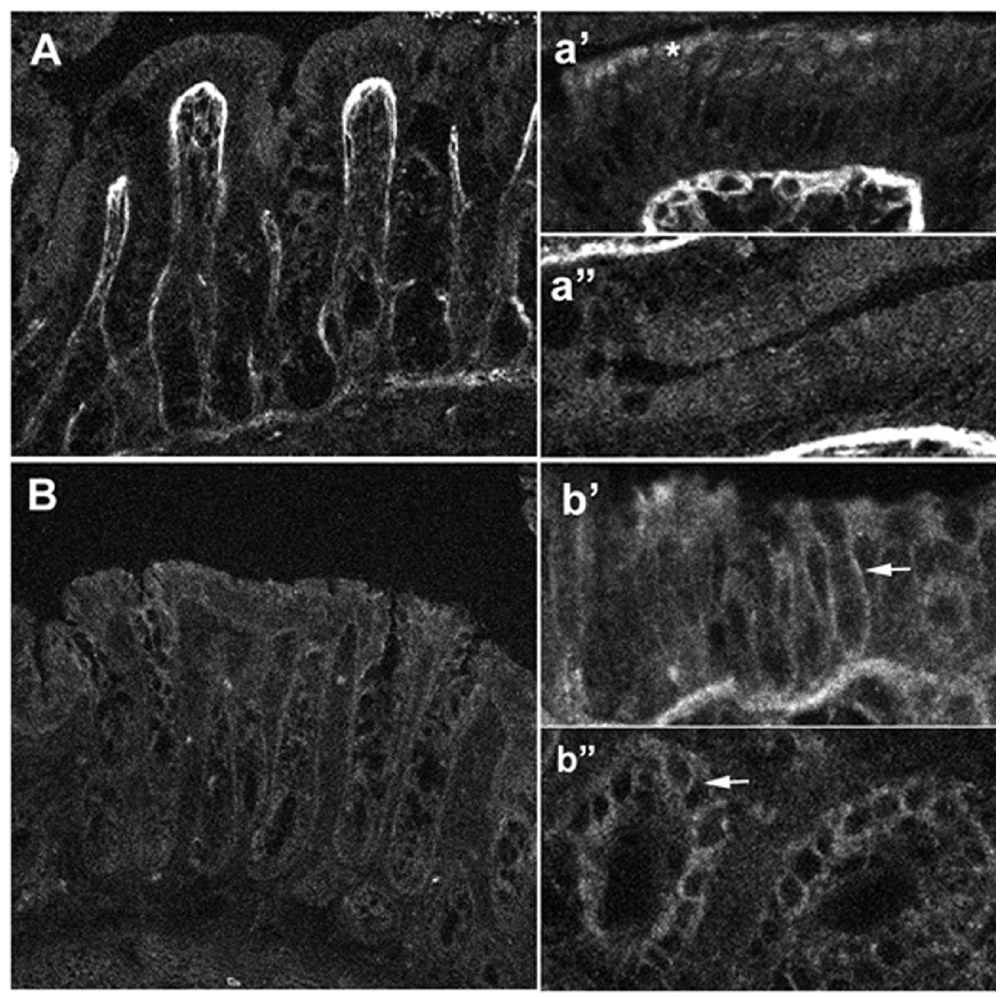
Figure 4. Immunocytochemical localization of NBCn1-like proteins in rat proximal and distal colon. [ A, a’, a’’ ] Rat proximal colon demonstrates weak epithelial staining for NBCn1 along the crypt to surface axis. The connective tissue underlying the epithelial cells is strongly fluorescent. Higher magnification of the surface cells [ a’ ] shows a rather punctuate apical signal [*]. High magnification of epithelial cells in the crypt region (a’’) demonstrates a weak diffuse localization. [ B, b’, b’’ ] Rat distal colon shows stronger staining for NBCn1. High magnifications of surface cells [ b’ ] and crypt cells [ b’’ ] clearly demonstrate basolateral membrane localization [ arrows ]. Smooth muscle cells were also strongly stained (data not